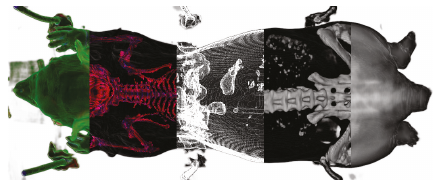
Figure 2: Selection of different renderings of CT data produced by the included volume renderer node and some supporting nodes. From left to right: solid with curvature as color; solid rescaled with curvature as color; edge/step function; solid rescaled;